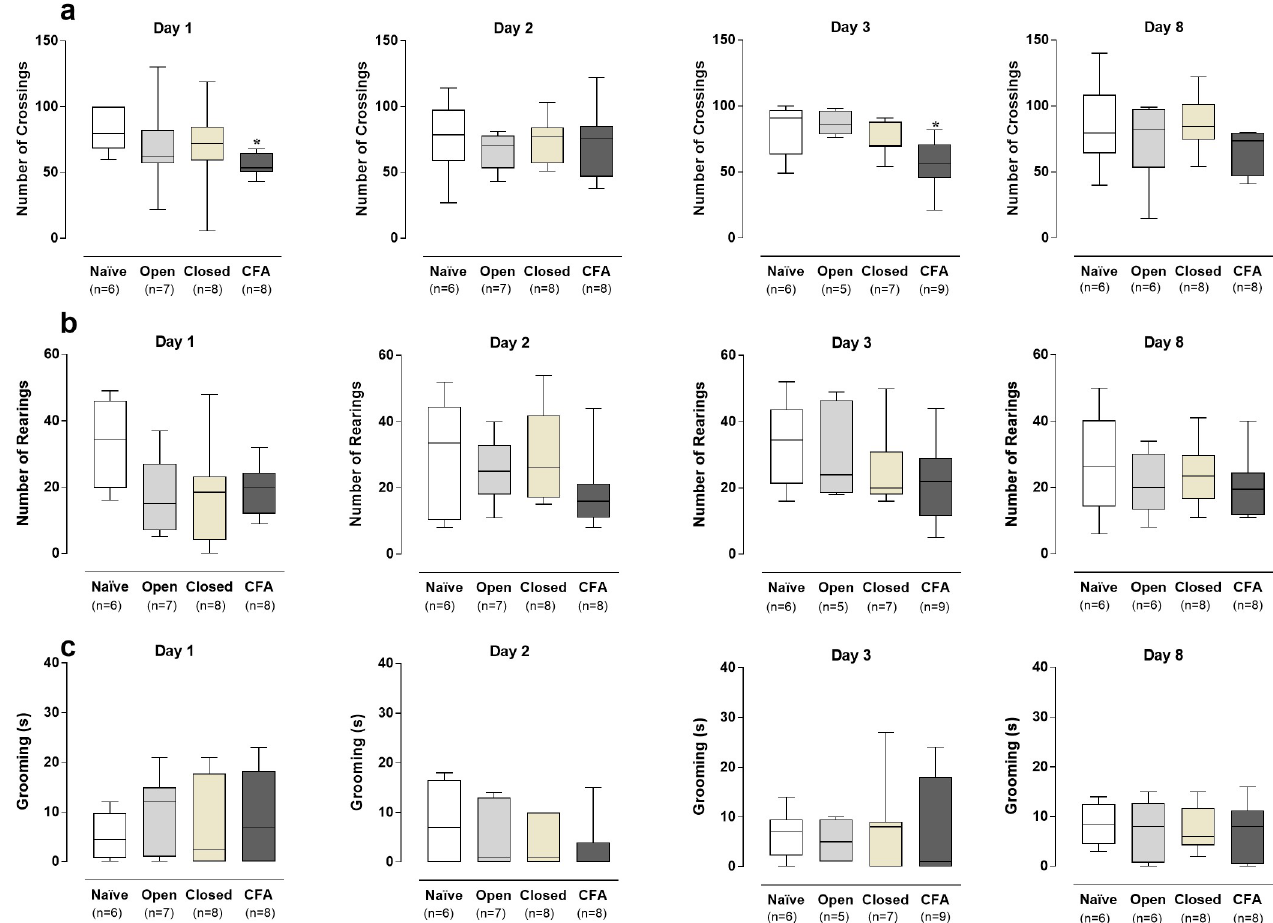
Fig 5. Behavioral assessment in the open-field arena. Crossing (A) and rearing (B) counts, and facial grooming time in seconds (C) of rats distributed into the different experimental groups, at 1, 2, 3, or 8 days after the dental surgical procedures. The box plots show the median of 5–8 experiments with the upper and lower quartiles. The whiskers indicate the maximal and the minimal values. ( � P < .05; Kruskal-Wallis plus Dunn’s